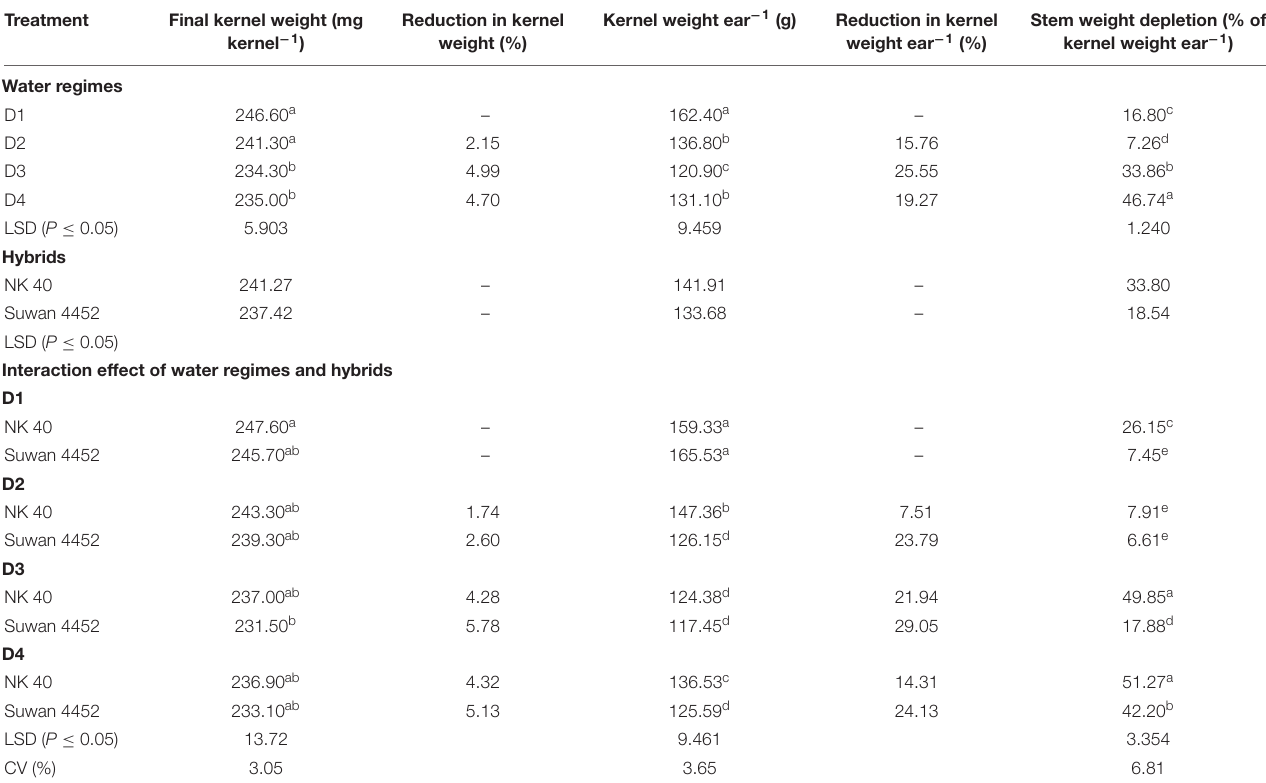
TABLE 5 | The effect of water regimes and hybrids on final kernel weight, kernel weight reduction, kernel weight ear − 1 , reduction in kernel weight ear − 1 , and stem weight depletion (% of kernel weight ear − 1 ) in Expt. 2.